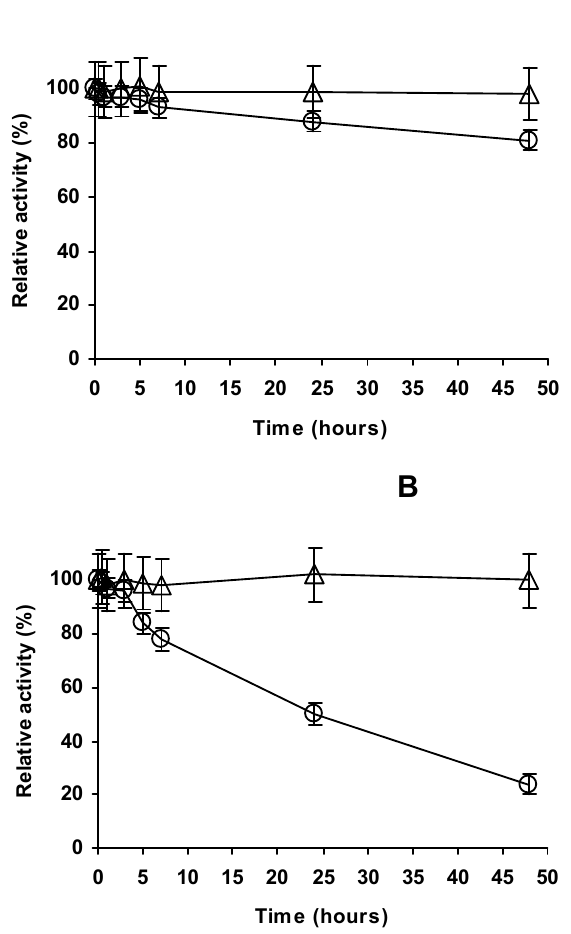
Figure 6. Immobilization courses of β -gal on pre-activated MANAE-glutaraldehyde supports at pH 8 and 250 mM sodium phosphate. The immobilization was performed using a: ( A ) 1/10; or ( B ) 1/3 support/enzyme suspension ratio at 25 °C. A support having 60 μ mol MANAE groups/g of support was utilized. All experiments were performed in triplicate and the values are given as mean value ± the experimental error. Other conditions are described in methods Section. Triangles: immobilization suspension; and Circles: immobilization supernatant.